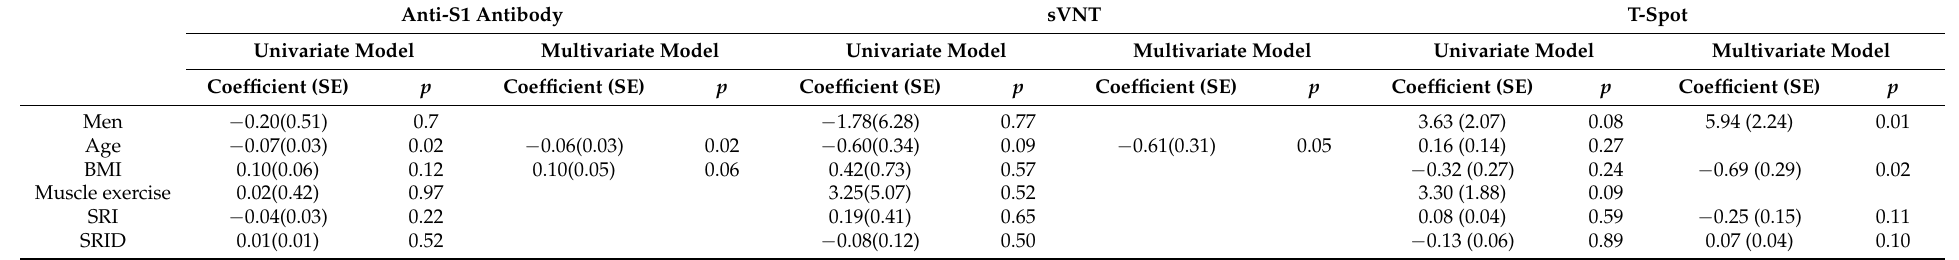
Table 3. Factors associated with the value of anti-S1 antibody, sVNT and T-spot assay using a multivariate linear regression